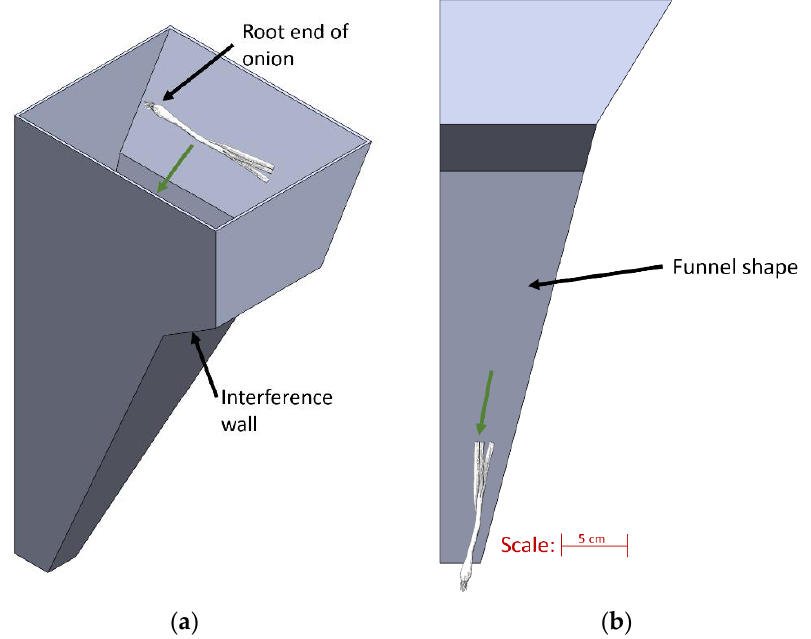
Figure 6. Design of the orienting funnel. ( a ) Isometric view; ( b ) Right-side view.